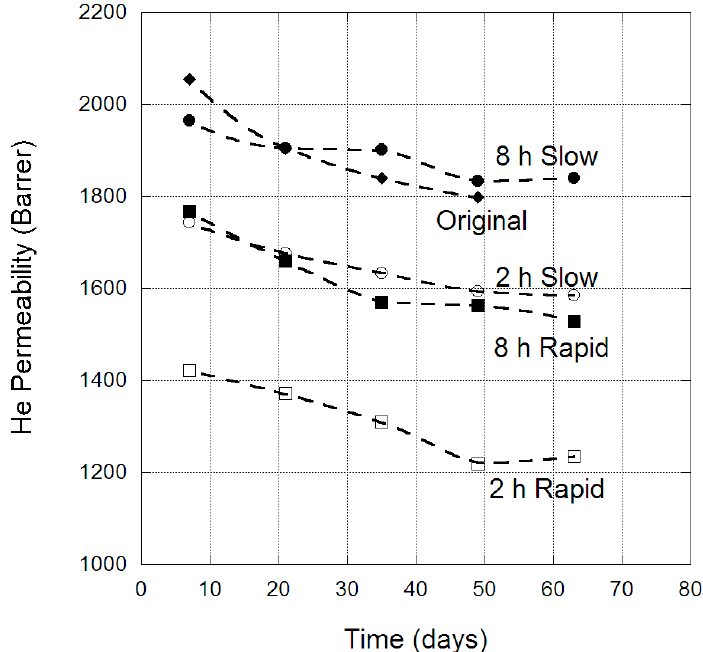
Figure 3. He permeability (barrer) in PIM-1 membranes over time, for the original and scCO 2 -treated states, at 35 °C.